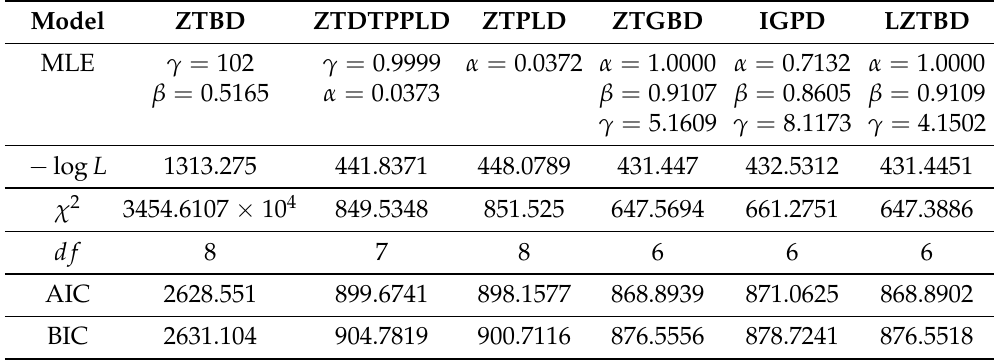
Table 8. Maximum likelihood estimates (MLEs), model adequacy measures, and χ 2 value for the Pakistan data